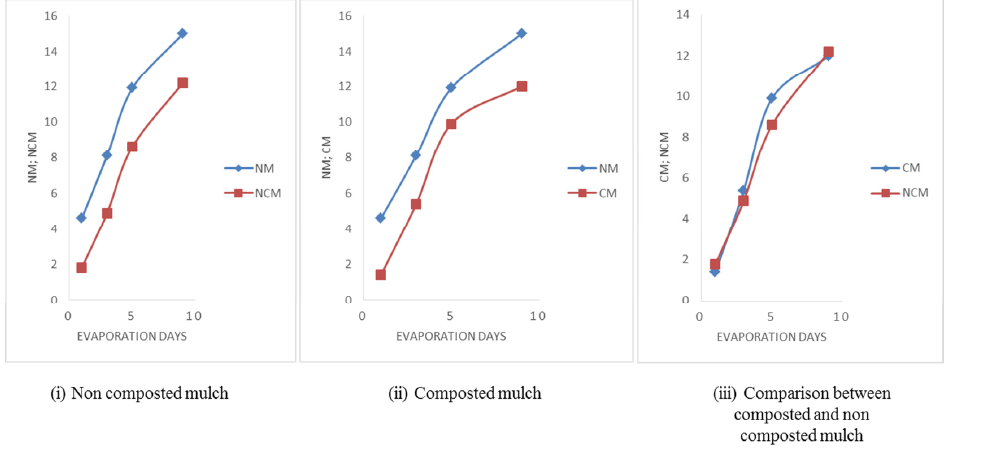
Fig. 2. Effects of Chromolena mulch material on soil evaporation NM = No mulch; NCM = non- composted mulch; CM = composted mulch